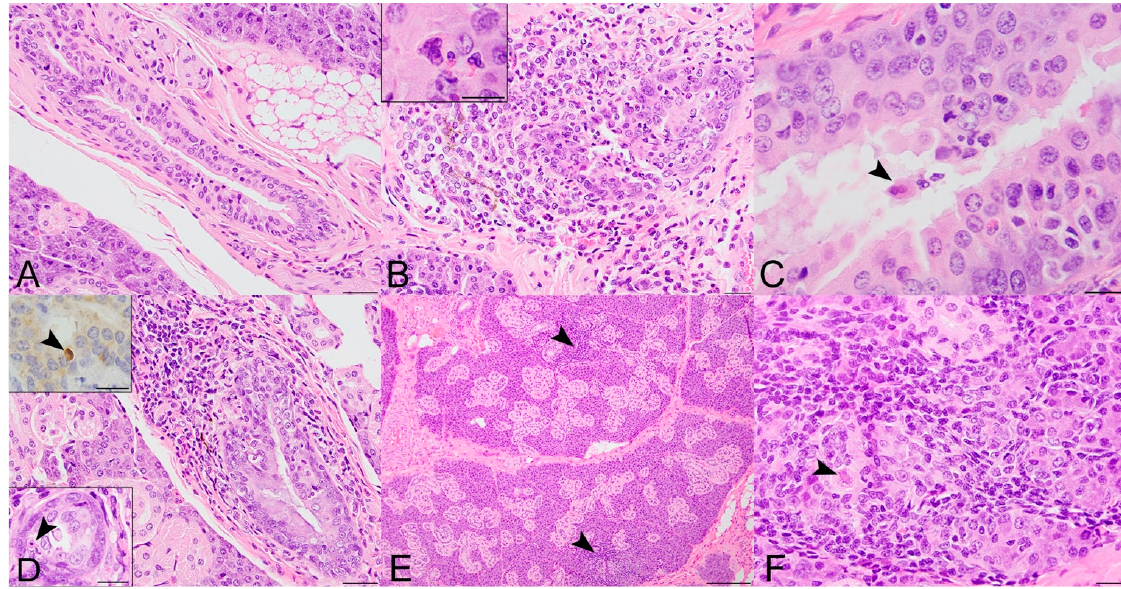
Figure 2. Histopathologic lesions in the salivary glands of SOSV-infected Egyptian rousette bats euthanized at 6, 9 and 21 DPI. ( A ) Salivary gland, control bat 290195. A normal interlobular duct is 1–3 cell layers thick and contains very low numbers of intraepithelial and peri-ductular resident immune cells. HE stain; original magnification = 400 × ; bar = 20 µ m. ( B ) Salivary gland, 6 DPI bat 284899. Acute sialodochitis characterized by a robust infiltrate of mononuclear and granulocytic inflammatory cells that expands the duct wall and surrounding connective tissue. Granulocytic cells, mononuclear cells and cellular debris fill and partially occlude the duct lumen. Inset: The luminal aspect of a different, but similarly affected duct contains an epithelial syncytium and several granulocytes. HE stains; original magnifications = 400 × (main image; bar = 20 µ m) and 1000 × (inset; bar = 10 µ m). This bat was qRT-PCR positive for SOSV in the salivary gland at necropsy and had SOSV RNA in the oral swabs on days 5 and 6 PI. ( C ) Salivary gland, 9 DPI bat 287014. The duct is multifocally infiltrated by low numbers of mononuclear and granulocytic cells. The lumen contains low numbers of neutrophils and a binucleated cell with abundant granular cytoplasm (suspected syncytium) (arrowhead). HE stain; original magnification = 400 × ; bar = 20 µ m. ( D ) Salivary gland, 21 DPI bat 289338. An interlobular duct is focally infiltrated and expanded by a mixture of mononuclear and granulocytic inflammatory cells. Bottom left inset: The wall of a smaller but similarly affected duct contains an apoptotic body that is shrunken and rounded with distinct cell borders and a pyknotic nucleus (arrowhead). HE stains; original magnifications = 400 × (main image; bar = 20 µ m) and 1000 × (inset; bar = 10 µ m). Top left inset: An apoptotic body in the wall of the same duct as the lower left inset has diffuse, moderate cytoplasmic immunoreactivity for cleaved caspase 3 (arrowhead). Immunohistochemical stain with 3-3 (cid:48) -Diaminobenzidine (DAB; brown) chromogen to visualize cleaved caspase 3 antigen and hematoxylin counterstain. Original magnification = 600 × ; bar = 20 µ m. ( E ) Salivary gland, 21 DPI bat 290040. Low magnification image of salivary gland acinar tissue showing multiple foci of mononuclear cells which expand the interstitium and focally obscure the acini (arrowhead). HE stain; original magnification = 200 × ; bar = 50 µ m. ( F ) Salivary gland, same 21 DPI bat as previous image. Higher magnification of one hypercellular focus showing interstitial expansion with numerous mononuclear inflammatory cells. One intralobular duct epithelial cell exhibits cytoplasmic swelling, peripheralization of nuclear material and accumulation of eosinophilic material within the nucleus suggestive of intranuclear inclusion material (arrowhead). HE stain; original magnification = 400 × ; bar = 20 µ